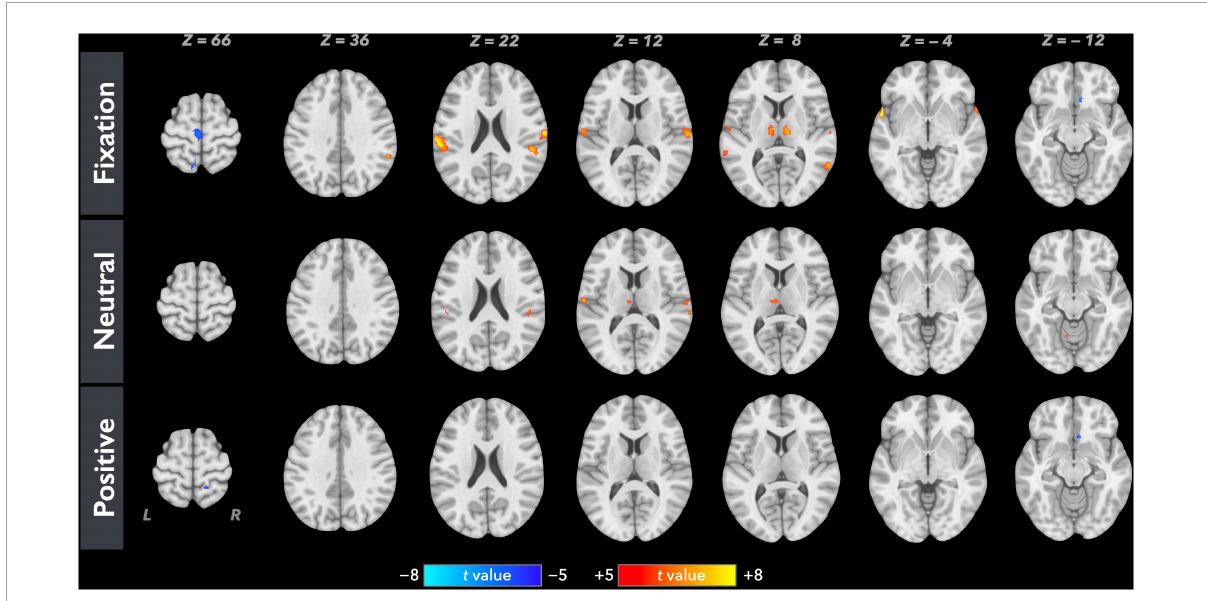
FIGURE1 Averaged neural activation maps for the study participants ( N = 35) in the fixation, neutral, and positive conditions (FWE-corrected, p < 0.05 and cluster size > 20 voxels).